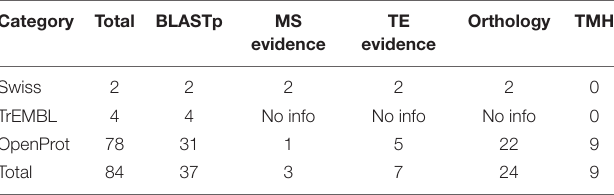
TABLE 2 | Additional features for sORFs identified from non-coding regions by MS 2 ReScore and